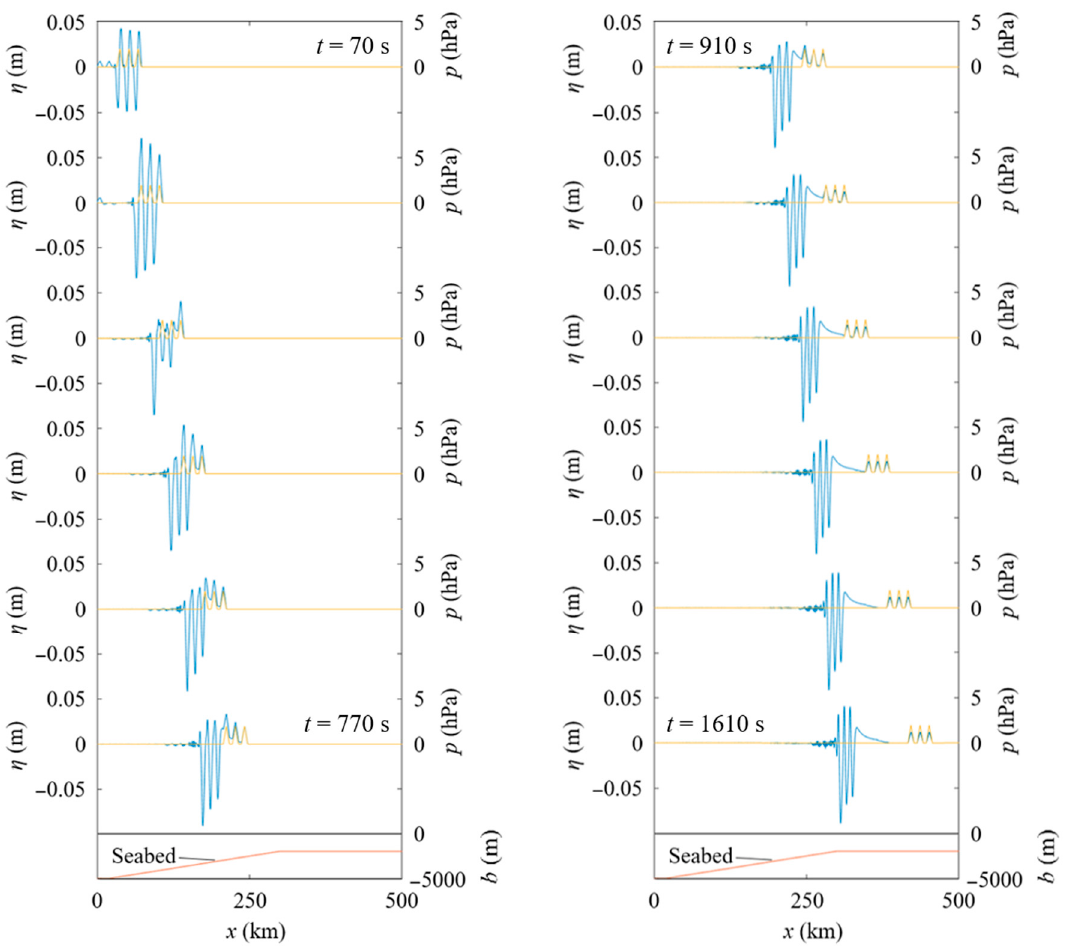
Figure 8. Time variation of the water surface profile every 140 s in 70 s ≤ t ≤ 1610 s in Case F, in which x 1 = 55 km and δ = 5 km in Figure 1; h on = 2000 m, x slope = 20 km, x on = 300 km, and the slope gradient β = 1.07 × 10 − 2 in Figure 2b. The blue, orange, and red lines indicate the water surface displacement η , atmospheric pressure p , and seabed position b , respectively.